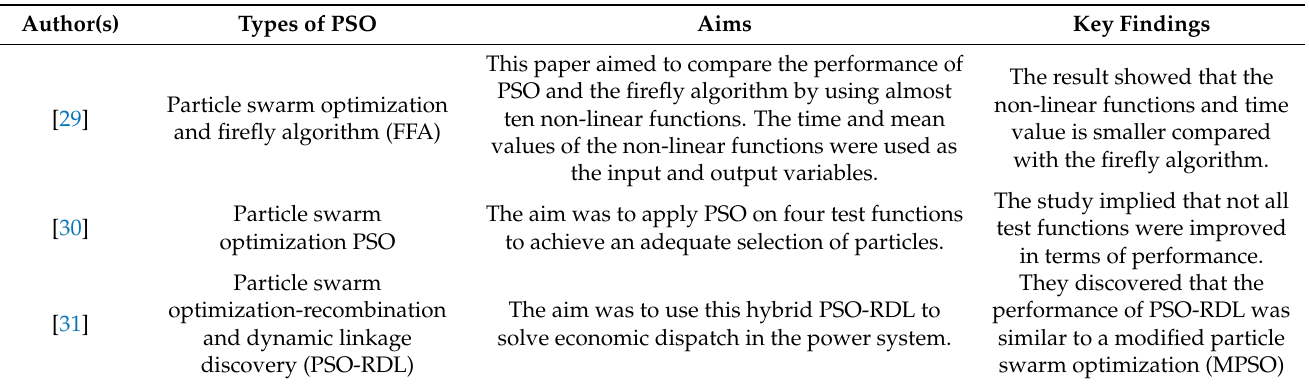
Table 1. Types of particle swarm optimization